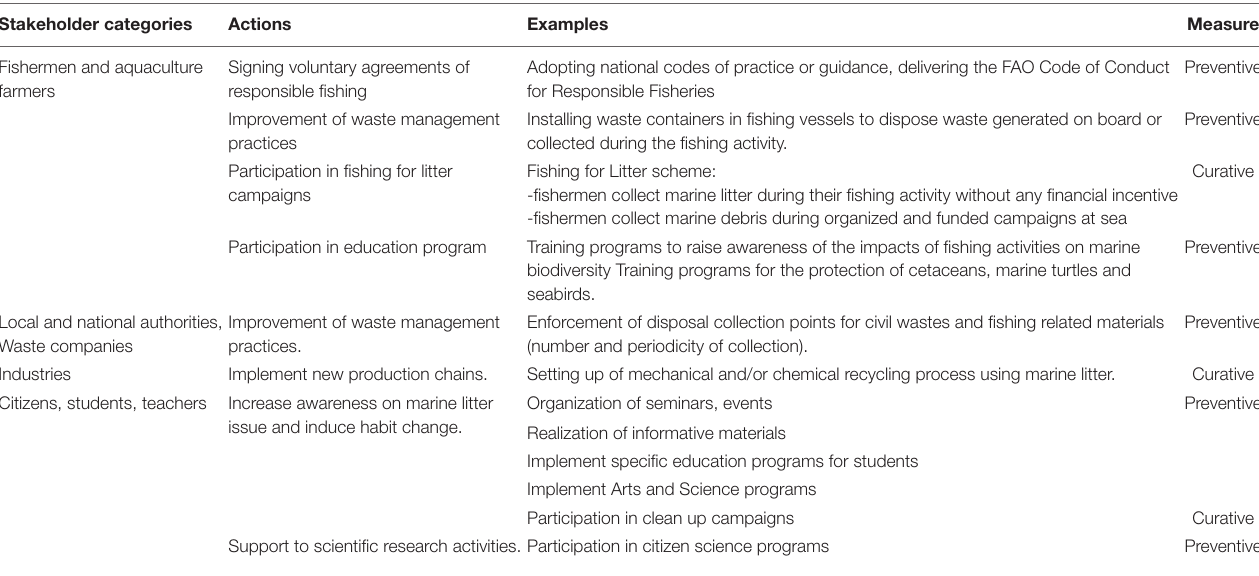
TABLE 3 | Management actions to induce a change in the perceptions and attitudes of the different stakeholder groups. Stakeholder